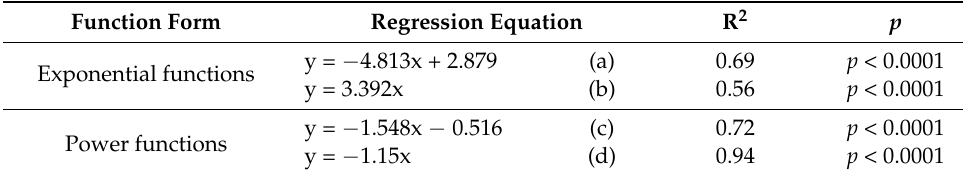
Table 2. MET models for muscle fatigue in the manual demolition tasks. Function Form Regression Equation R 2 p Exponential